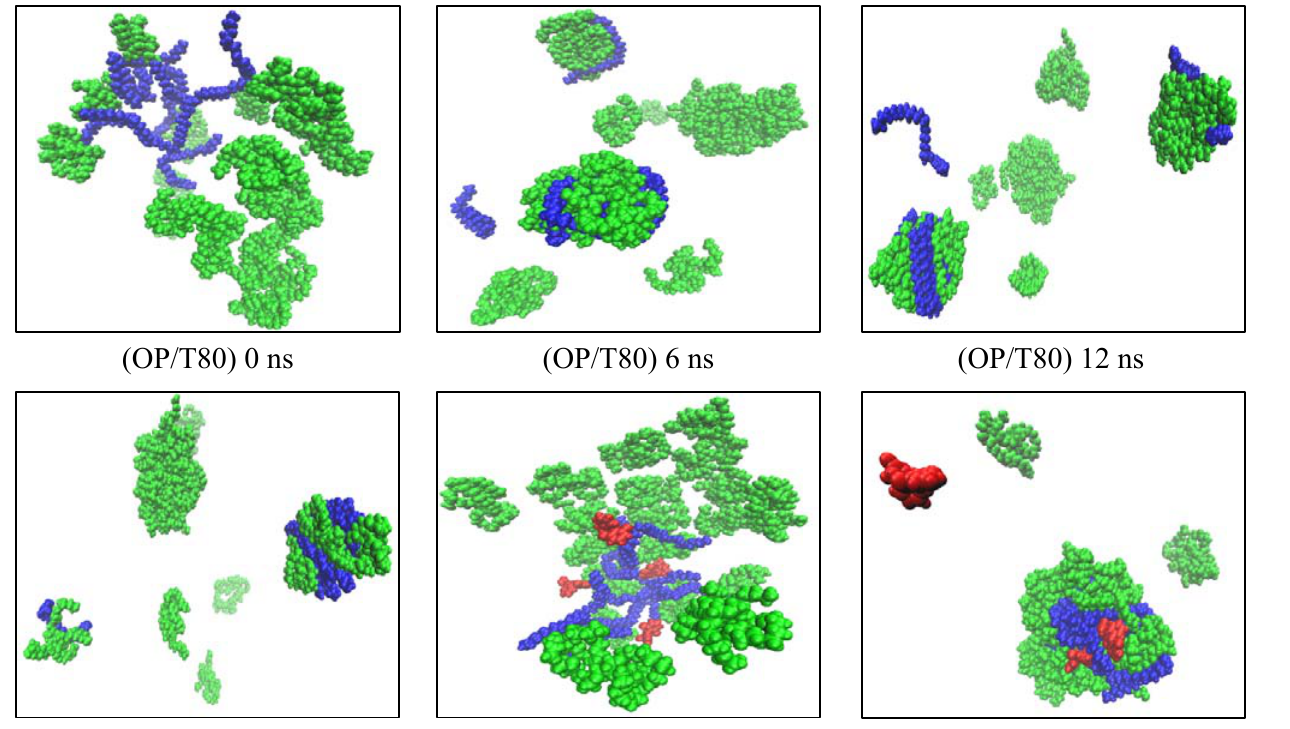
Figure 2. Snapshot pictures during molecular dynamics (MD) simulations of oleyl palmitate (OP)/Tween80 (T80) & OP/T80/diclofenac (DIF) systems at 300 K; OP (Blue); T80 (green); DIF